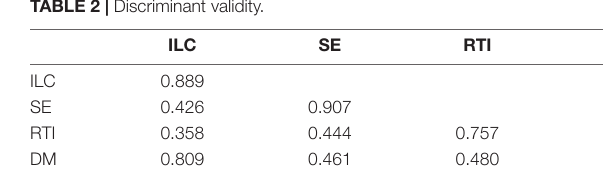
TABLE 2 | Discriminant